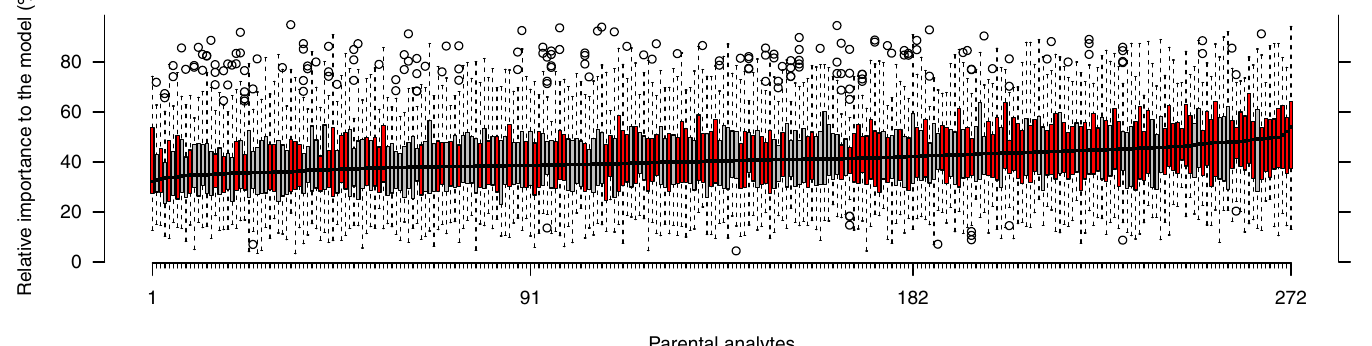
Fig 4. Ranking of parental features based on the decreasing median relative importance to the SVM-W classifier. The median relative importance to the model (%) of the various Dent (maternal, red) and Flint (paternal, grey) analytes exhibits an approximately linear decrease along the ranking (right to left).